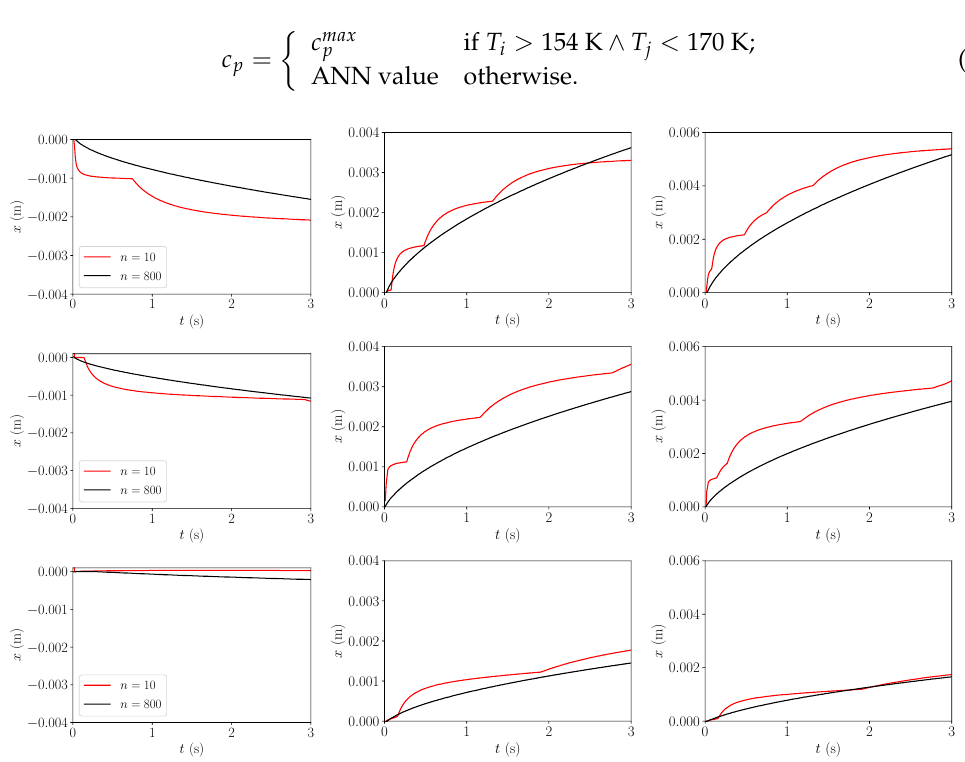
Figure 18. Plot of the movement of the temperature curves. The left column of plots tracks the x position of a certain lower temperature threshold, from top to bottom the temperature thresholds were T = 100.1,101,120 . The middle column of plots tracks the x position where a certain high { } temperature threshold, from top to bottom the temperature thresholds were T = The far right column is then the difference between the lower and higher temperature thresholds. The plots were scaled using the initial value so that the plots start at the